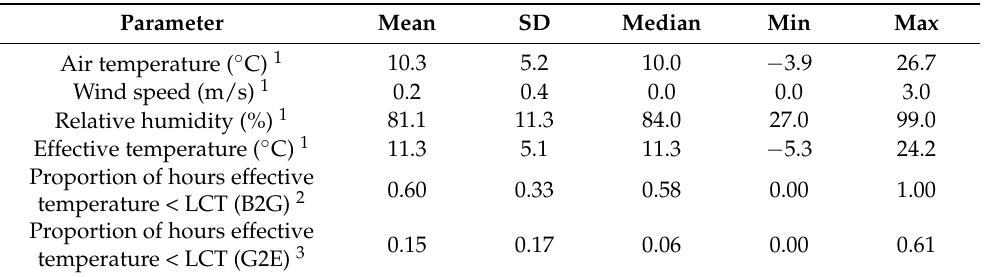
Table 4. Description of climate parameters to which calves were exposed over the duration of the study.